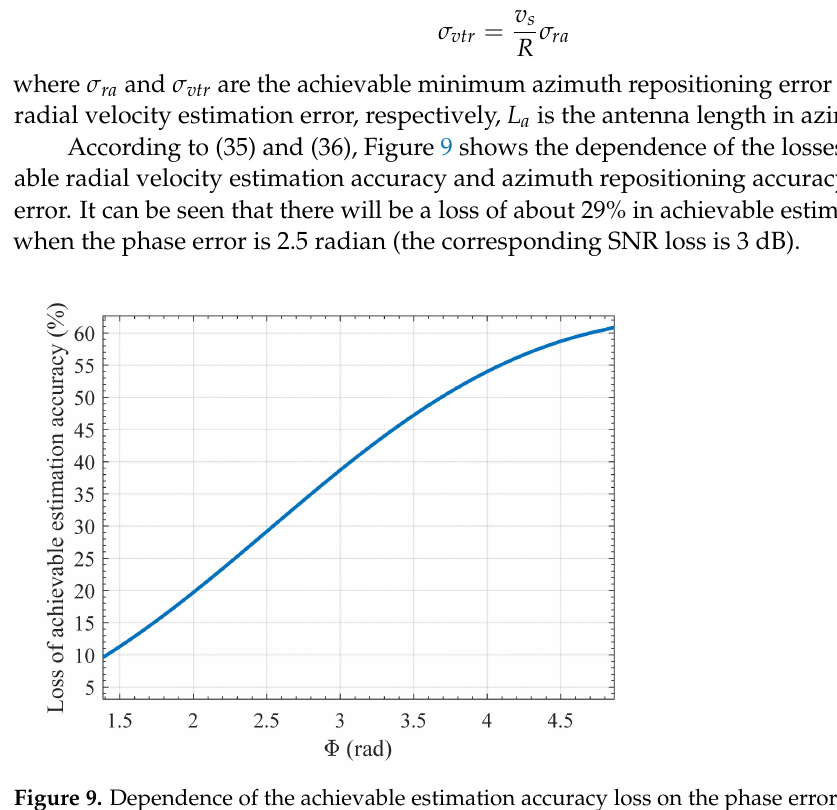
Figure 9. Dependence of the achievable estimation accuracy loss on the phase